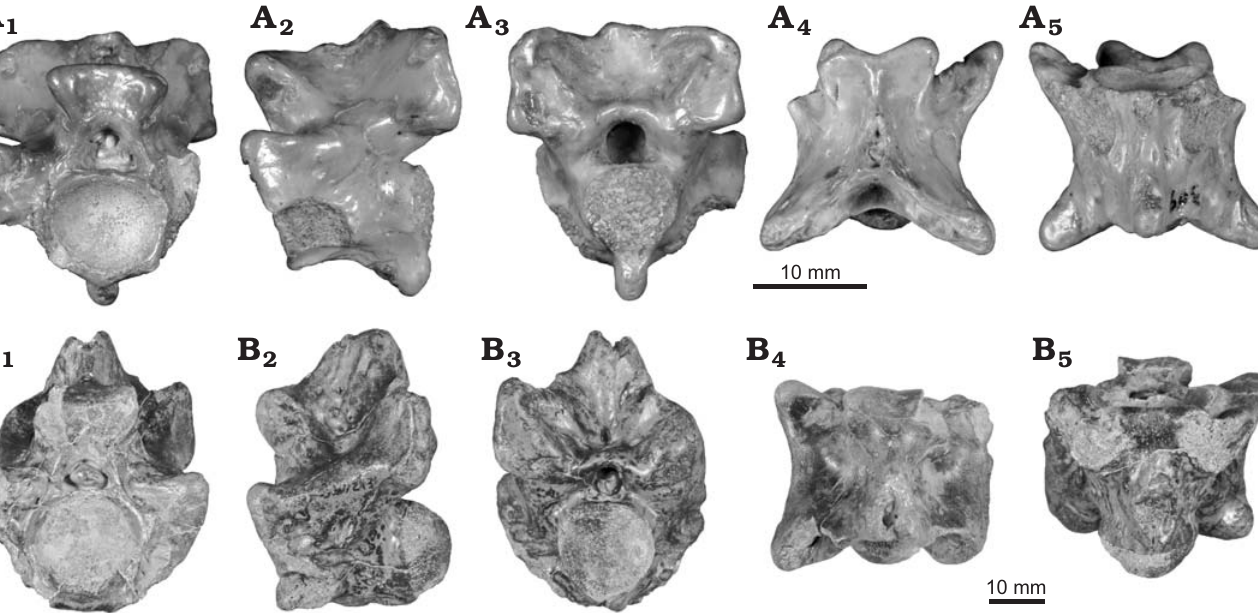
Fig. 5. Anterior (A) and posterior (B) trunk vertebrae of palaeophiid snake Palaeophis colossaeus Rage, 1983 from the Eocene of Tamaguélelt Formation, Mali. A . CNRST-SUNY 309; in anterior (A 1 ), lateral (A 2 , reversed to facilitate comparisons), posterior (A 3 ), dorsal (A 4 ), and ventral (A 5 ) views. B . CNRST-SUNY 293; in anterior (B 1 ), lateral (B 2 ), posterior (B 3 ), dorsal (B 4 ), and ventral (B 5 )